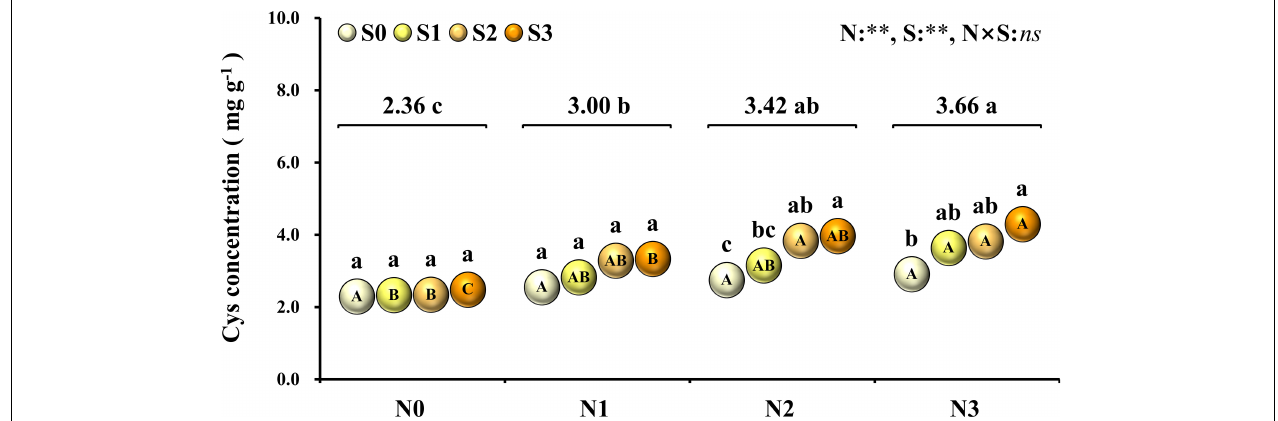
FIGURE 6 | Concentration of cysteine in maize grains at different N and S rates. The data are the means of four replicates. The lowercase letters above the spheres indicate the significant differences between the different S rates at the same N level, and the different uppercase letters in the spheres indicate the significant differences between the different N rates at the same S level. The number on the horizontal line above each group of spheres indicates the average value of concentration of cysteine at different N levels, and the lowercase letters after the numbers indicate the significant difference in concentration of cysteine at different N levels. The variance analysis used two-way ANOVA ( ∗∗ P < 0.01, ns P > 0.05).